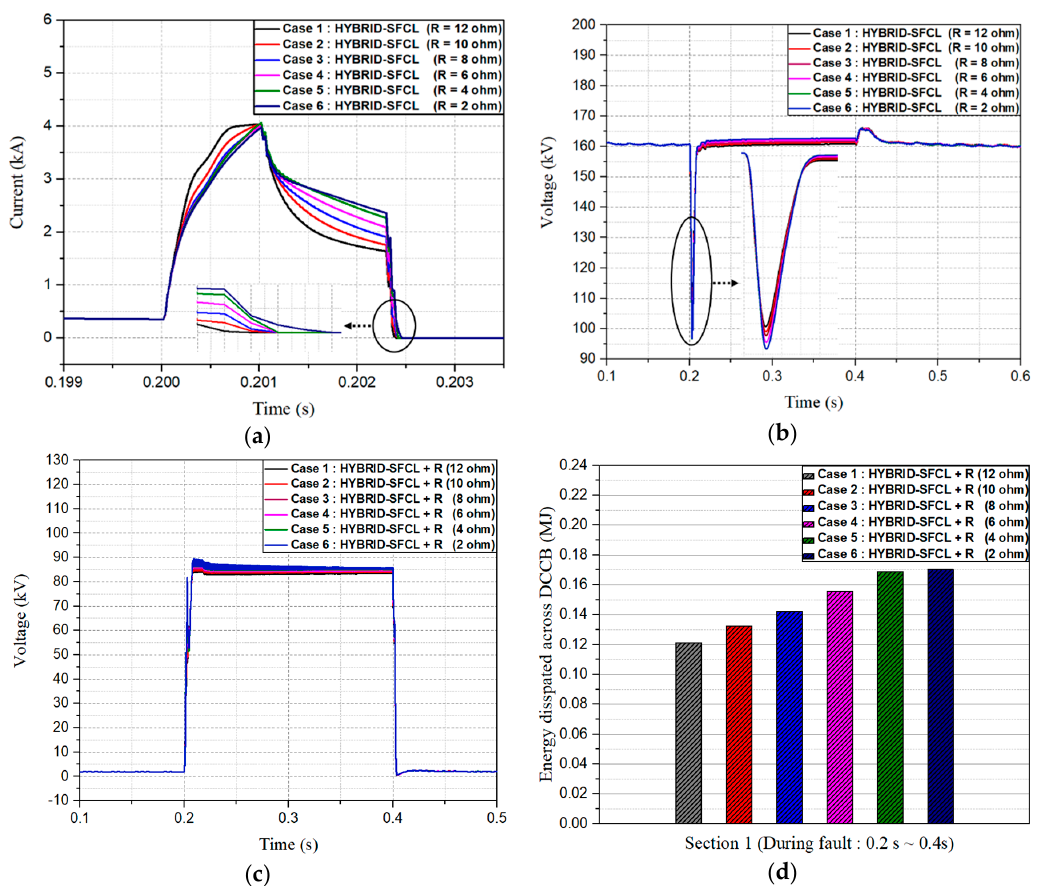
Figure 18. The DC current and voltage waveform in transient state in protection scheme (Case 3): ( a ) current waveform in fault period; ( b ) voltage waveform in transient state; ( c ) voltage waveform across DCCB; ( d ) energy dissipation across DCCB.